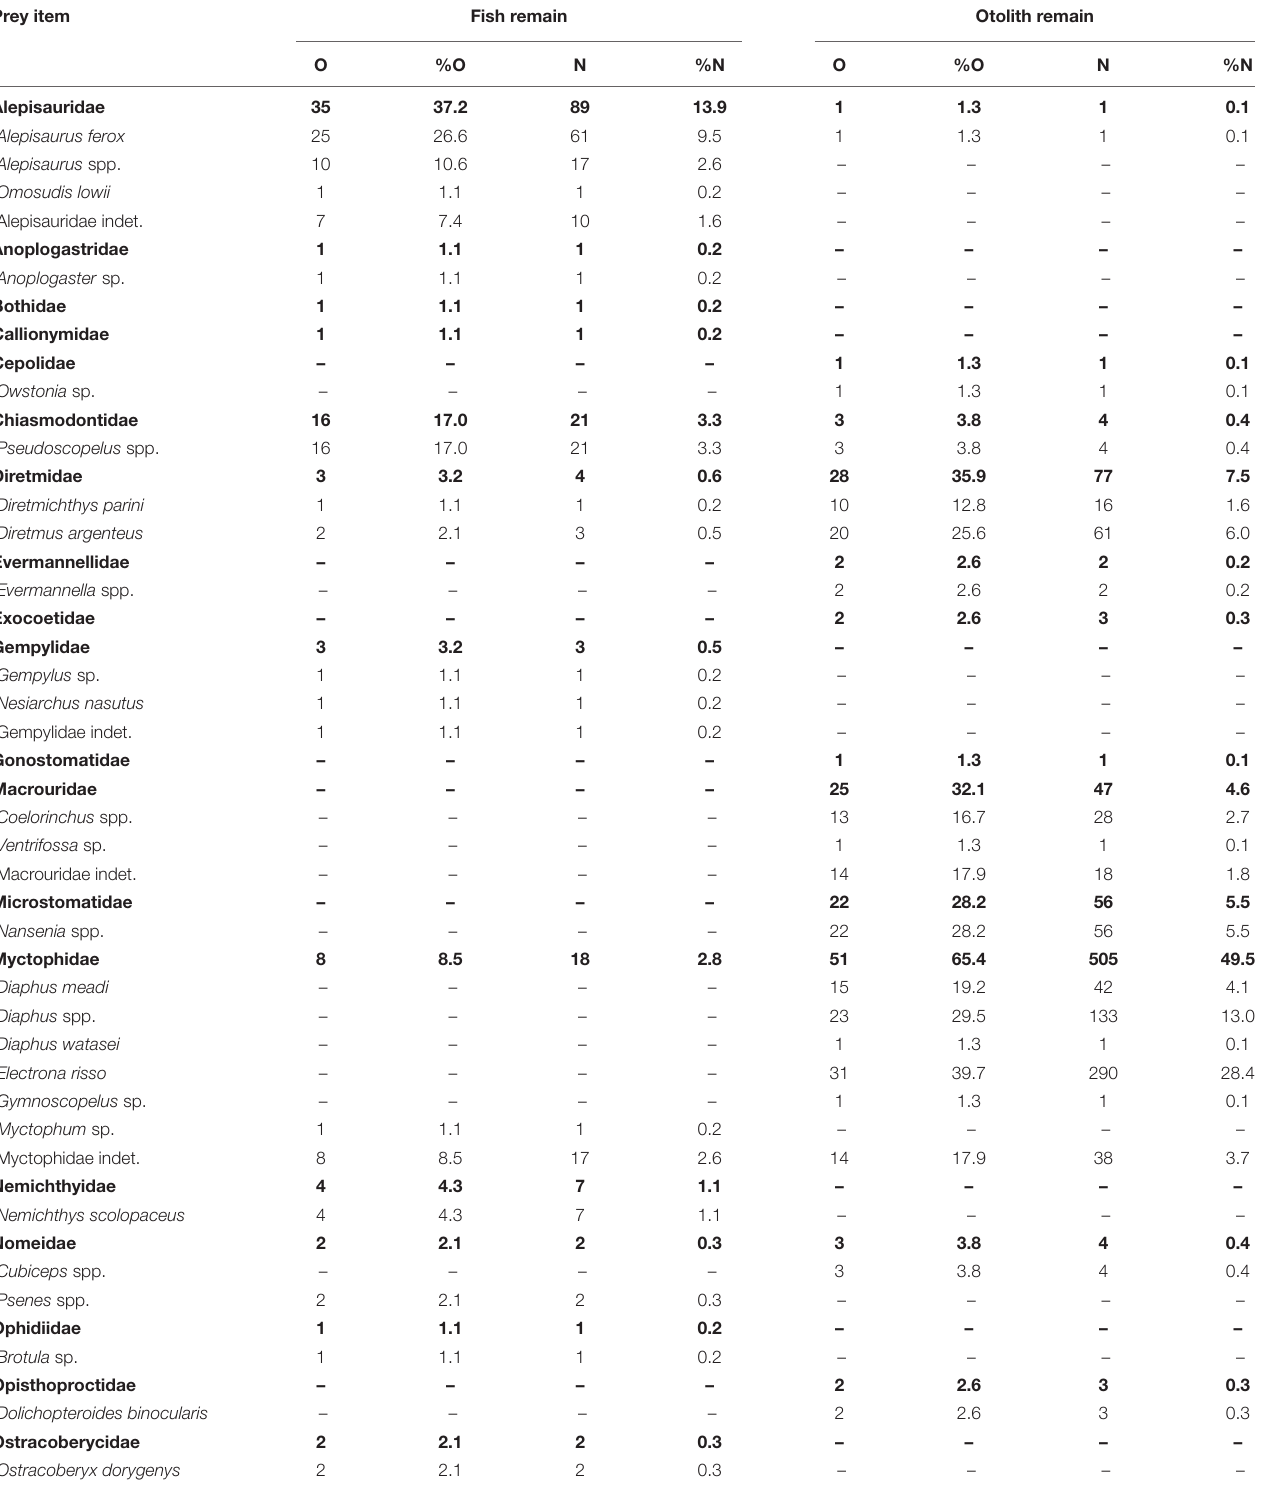
TABLE 2 | Number of stomachs containing the prey item (O), percentage of occurrence (%O), number of prey items (N), and numerical percentage (%N) for fish and otolith remains of bigeye tuna Thunnus obesus . Prey